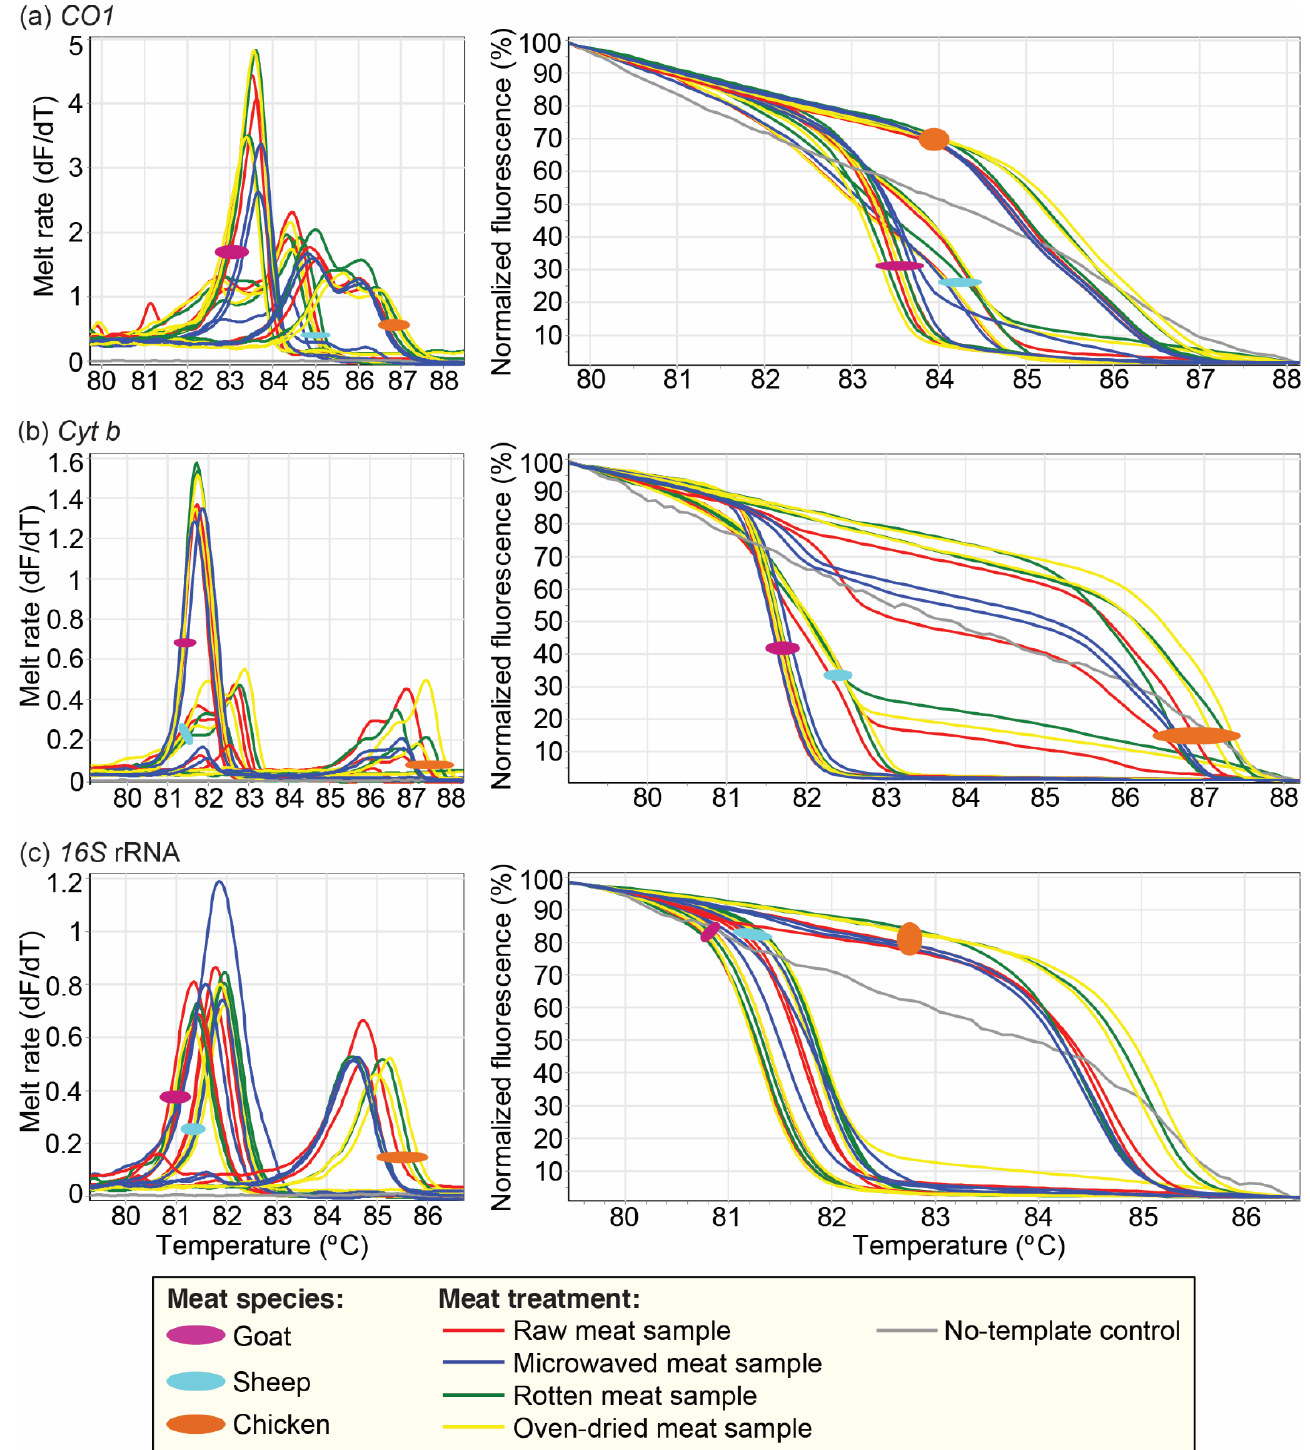
Figure 4. PCR-HRM profiles of representative reference samples exposed to different physicochemical conditions. Goat, sheep, and chicken meat samples were exposed in replicate to different conditions—raw, rotten, oven-dried, and microwaved. Their PCR-HRM profiles were then assessed using CO1 , cyt b , and 16S rRNA. For each marker, the HRM profiles are represented as melt rates and normalized HRM profiles. Melt rates are represented as changes in fluorescence units with increasing temperatures (dF/dT), and HRM profiles are represented as percent fluorescence with increasing temperatures for ( a ) CO1 , ( b ) cyt b , and ( c ) 16S rRNA markers.